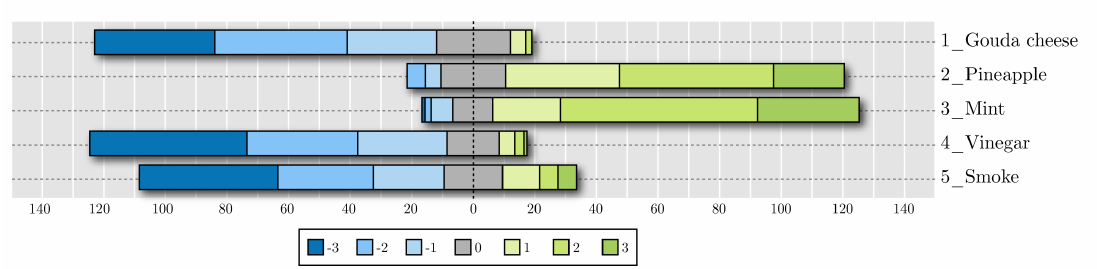
Figure 11. Acceptance results for taste evaluations.